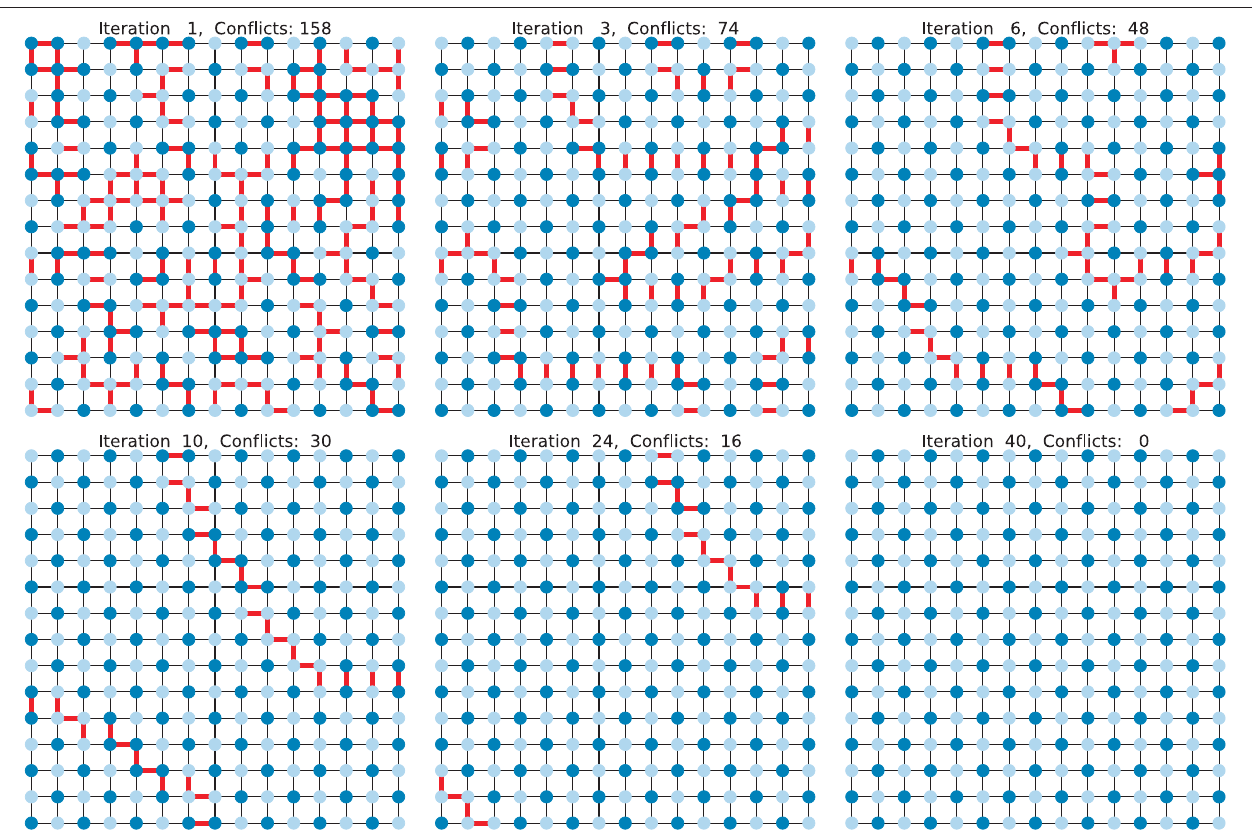
FIGURE 1 | A 2-coloring for a grid graph found by RUN-CSP in 40 iterations. Con fl icting edges are shown in